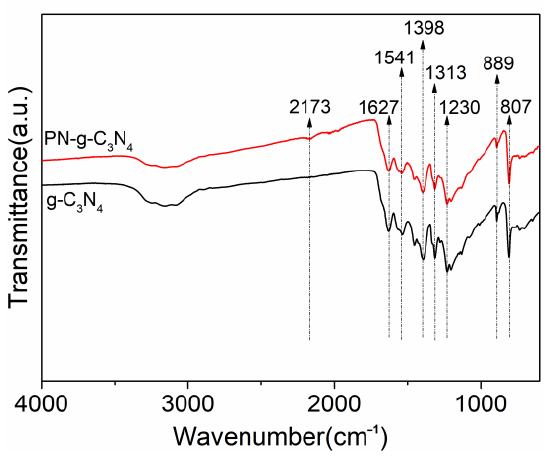
Figure 4. FTIR spectra of g-C 3 N 4 and PN-g-C 3 N 4 samples.